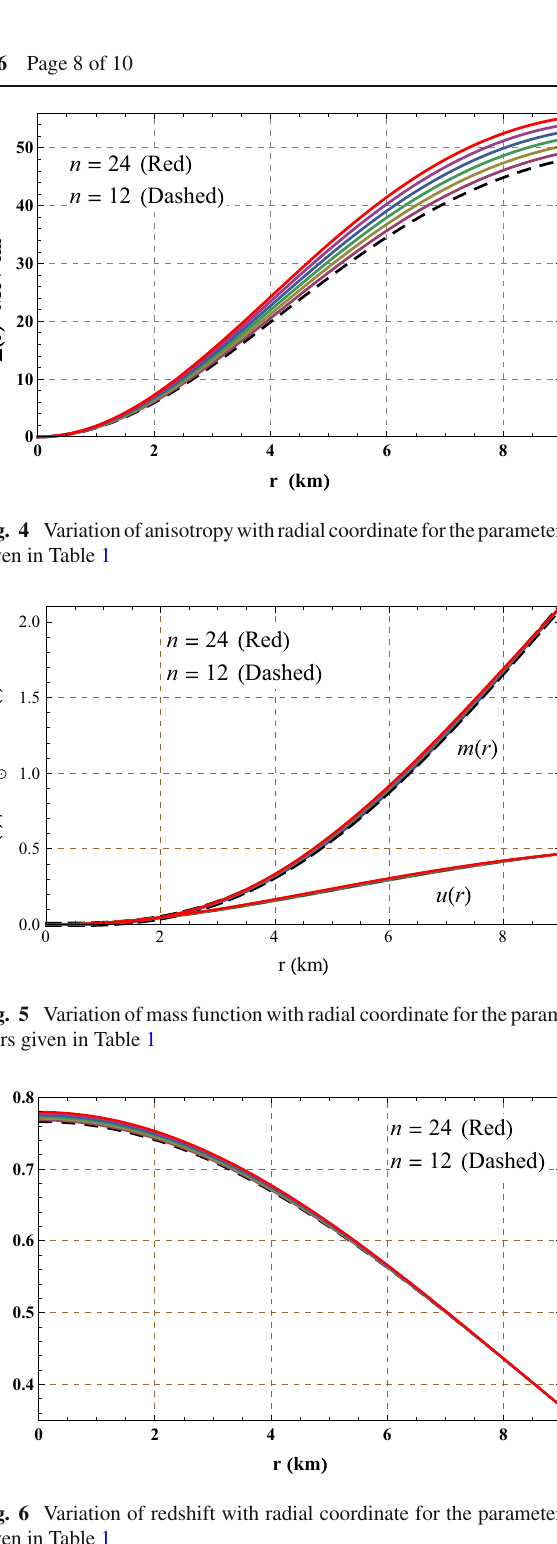
0.469 is with Buchdahl limit. The redshift at the center yield by the solutions is minimum for n = 12 and maximum for n = 24; however, the surface redshift is exactly equal for all